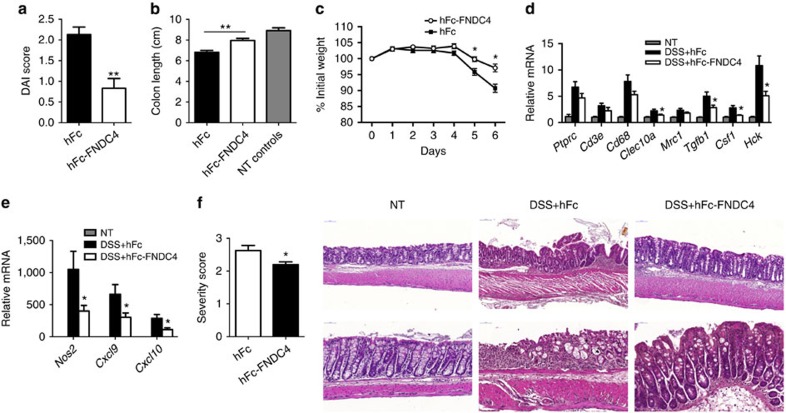
FNDC4 improves colitis in mice.DSS-induced colitis model. Mice were administered DSS from day 0 to 5 and were injected with hFc-FNDC4 or hFc control protein on days 0, 2 and 4. N=10 mice per group. This experiment was performed three times (of which the last experiment was blinded, blinding was performed by a colleague not involved in the study) with similar results. (a) DAI (disease activity index). **P<0.001, Mann–Whitney rank test. (b) Colon length. **P<0.001, Student's T-test. The non-treated (NT) control group consisted of 5 age- and gender-matched controls that did not receive DSS. (c) Body weight curve. *P<0.05, Student's T-test. (d–e) Gene expression, selected genes. Mean±s.e.m., *P<0.05 and q<0.10; two-sided Student's T-tests of hFc versus hFc-FNDC4, followed by the Benjamini-Hochberg false discovery rate (FDR) correction for multiple testing. (f) Histopathology. Colitis severity assessment and representative images. Scores are mean±s.e.m. *P<0.05, Mann–Whitney rank test.